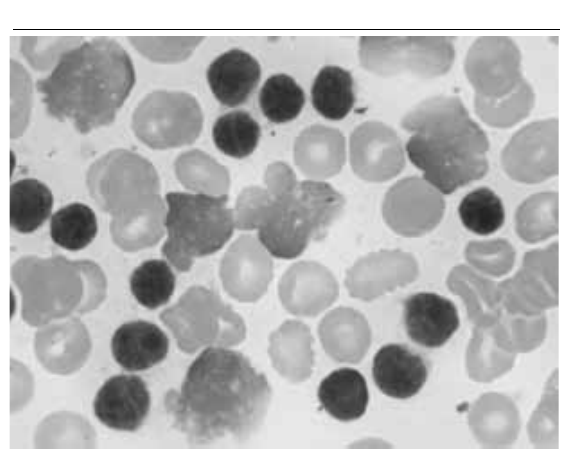
figurE – Lymphocytes and Gumprecht